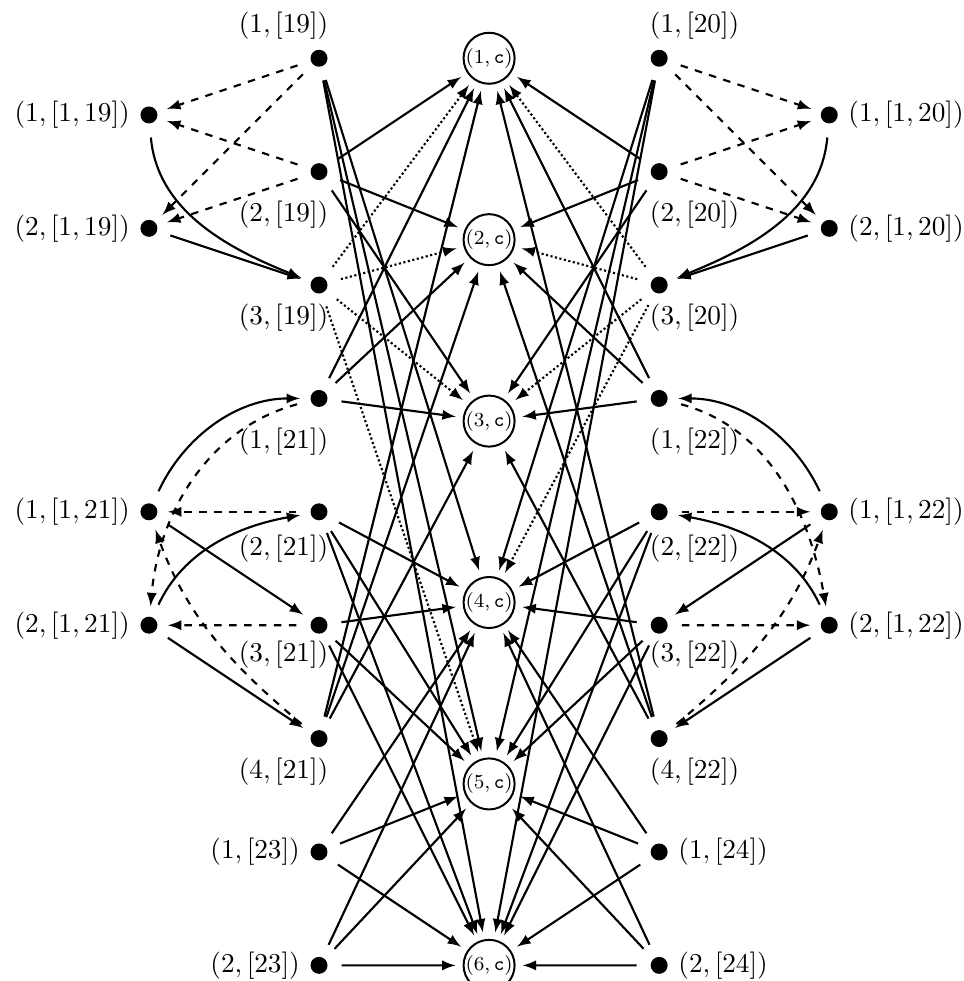
Figure 8: Partial orientation D for H for s = 6, k =